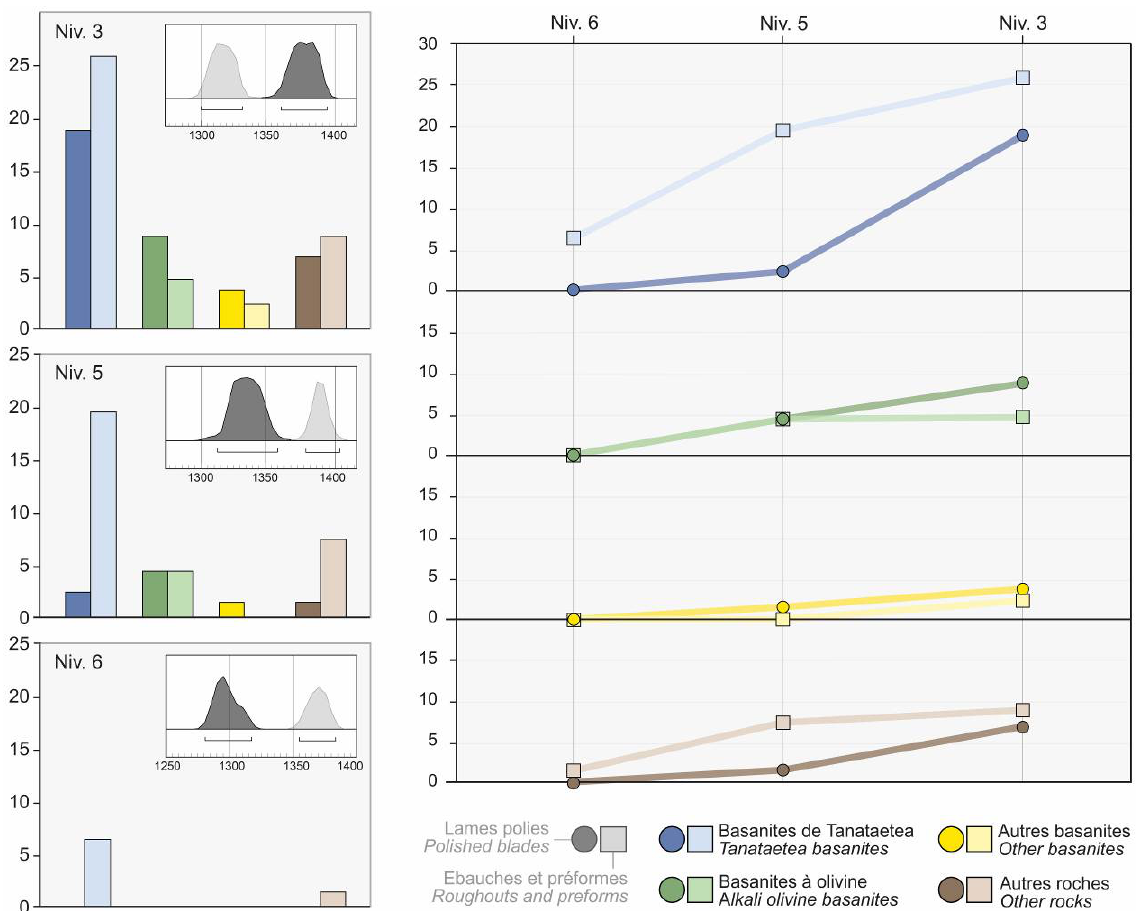
Figure 20. Distribution des produits façonnés par matières premières et niveau d'occupation du site d'Atiahara. Figure 20. Distribution of knapped products and raw materials in the Atiahara occupation